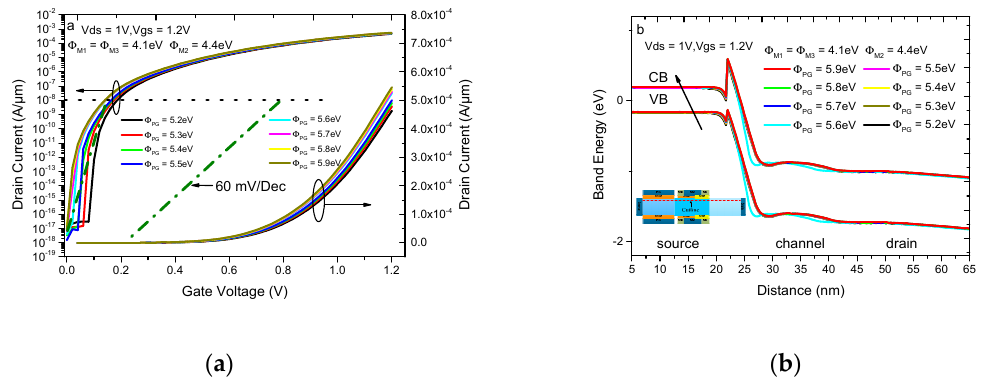
Figure 7. ( a ) Transfer characteristics of the DMGE-HJLTFET with different polar gate workfunction ( Φ PG ); ( b ) the variation of energy band diagram with different polar gate workfunction ( Φ PG ). Figure 8a–d indicate the impact of the control gate workfunction ( Φ M2 ) on transfer characteristics,